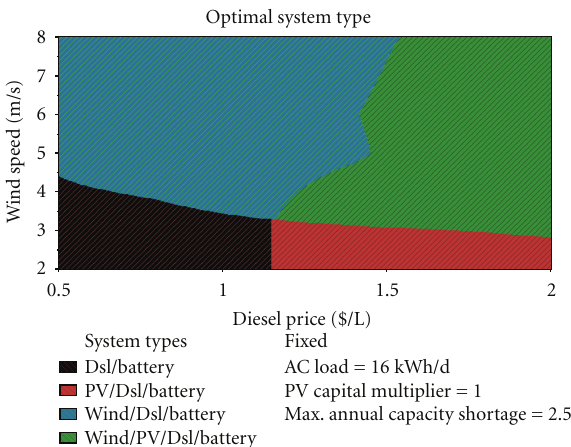
Figure 8: Results for the optimization space of the system of Figure 5 disconnected from the grid, with PV capital multiplier equal to 0.75.